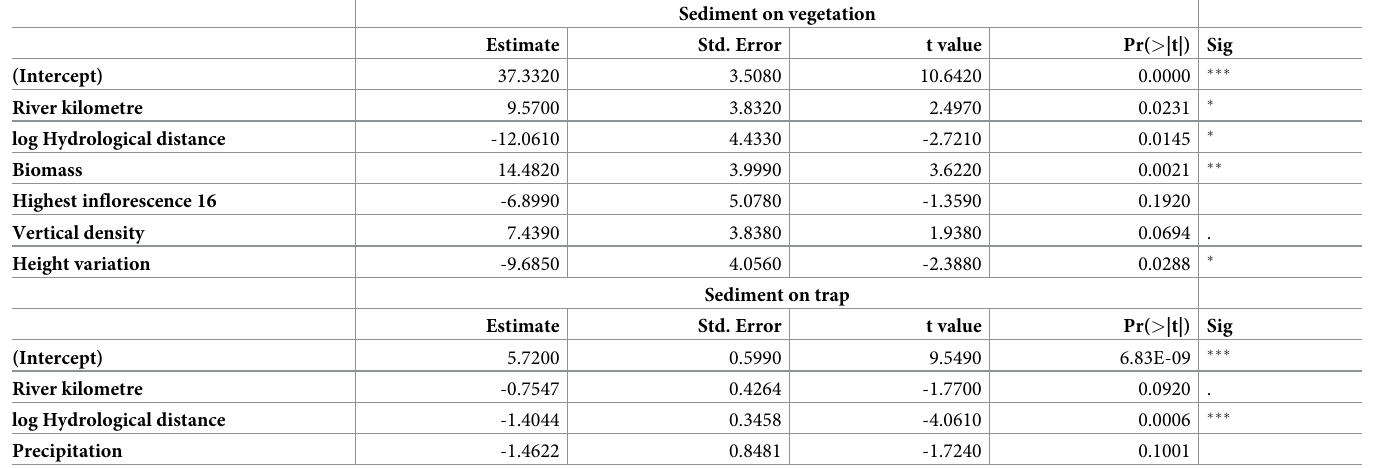
Table 3. Model results. Final multiple regression model results of the sedimentation on the vegetation and on the